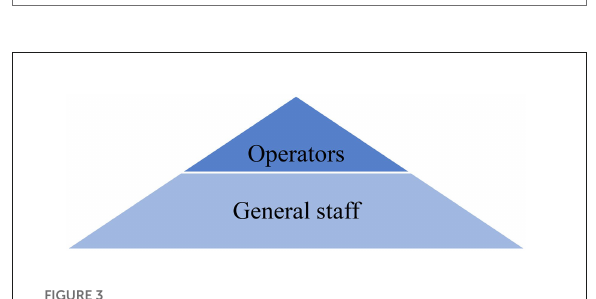
FIGURE 2 Staff turnover circle